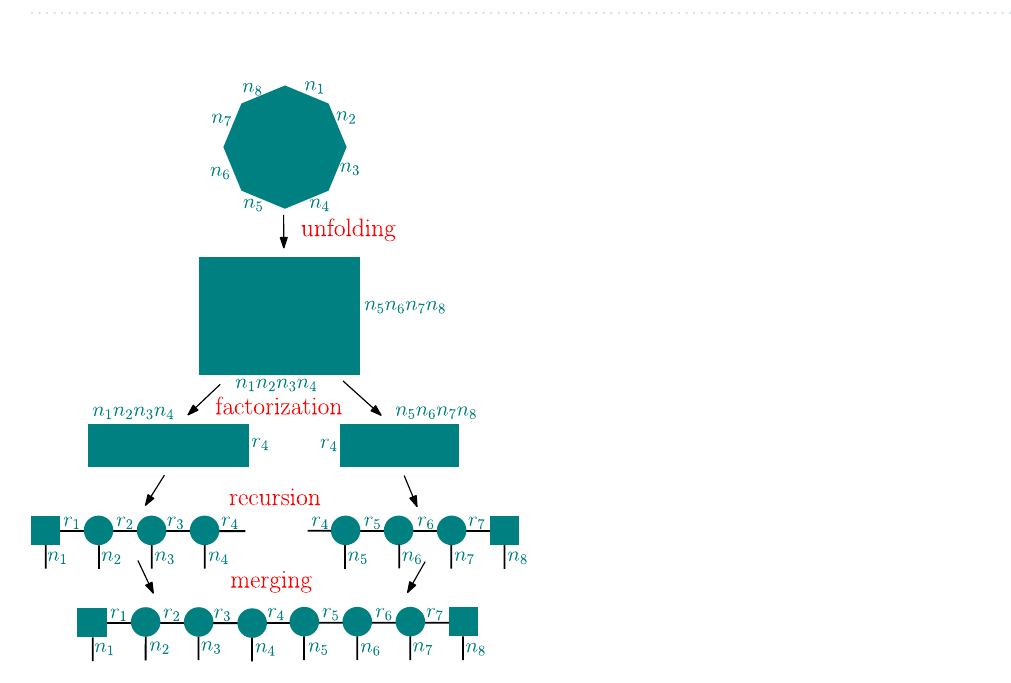
Figure 4. The phases of the recursive tensor train algorithm. The octagon is an input order-8 tensor, rectangles are matrices, and circles are order-3